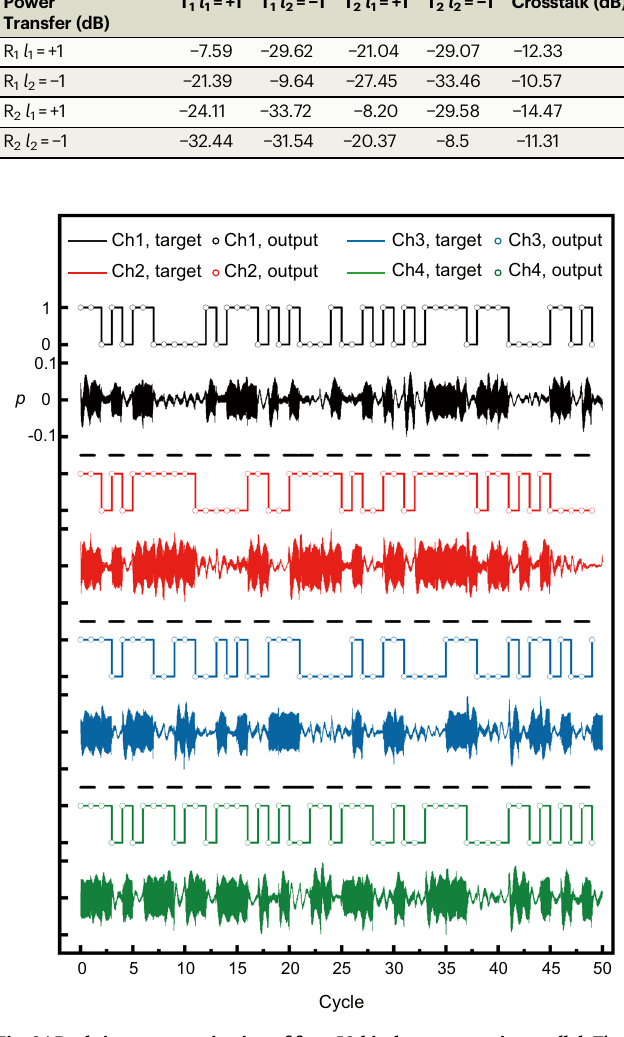
Fig. 3 | Real-time communication of four 50-bit data streams in parallel. The comparison between the target data stream and the received output in the four channels, and the measured time-domain signals in each pulse period in four channels. Each of two transmitting units emits a synthesized vortex beam with l − 1,openingfourindependentchannelsmarkedbyCh1,Ch2,Ch3,and l 1 =+1and 2 = Ch4